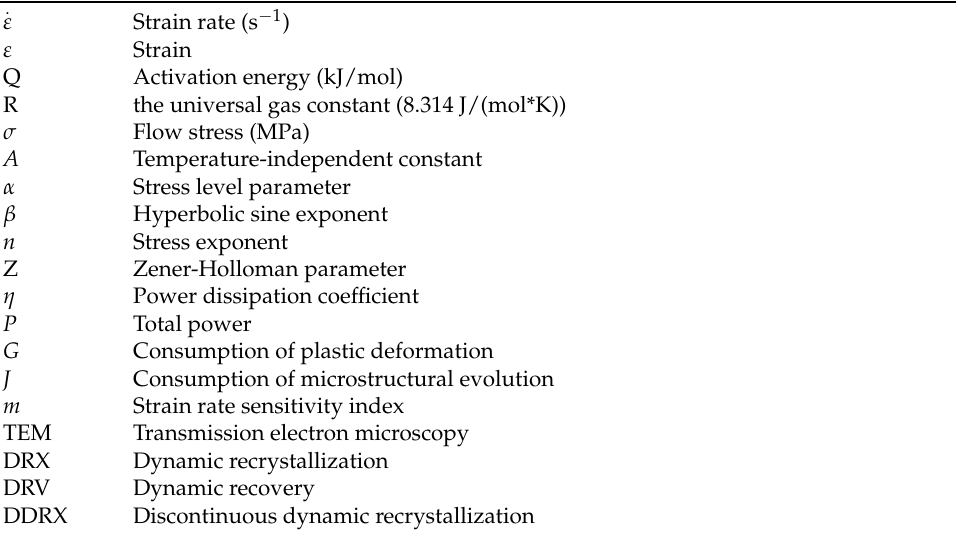
Figure 1. Schematic diagram of ( a ) hot compression process and ( b ) the dimensions of specimens. Table 2. Nomenclatures of the physical quantities and